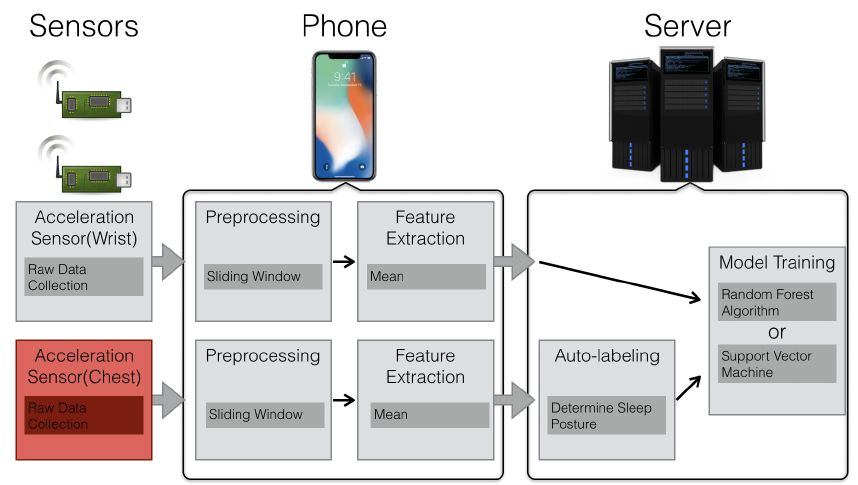
Figure 6. Overview of the data processing framework. The flow chart represents the pipelines of processing data. The device icons above the flow chart show the devices in which the processing elements takes